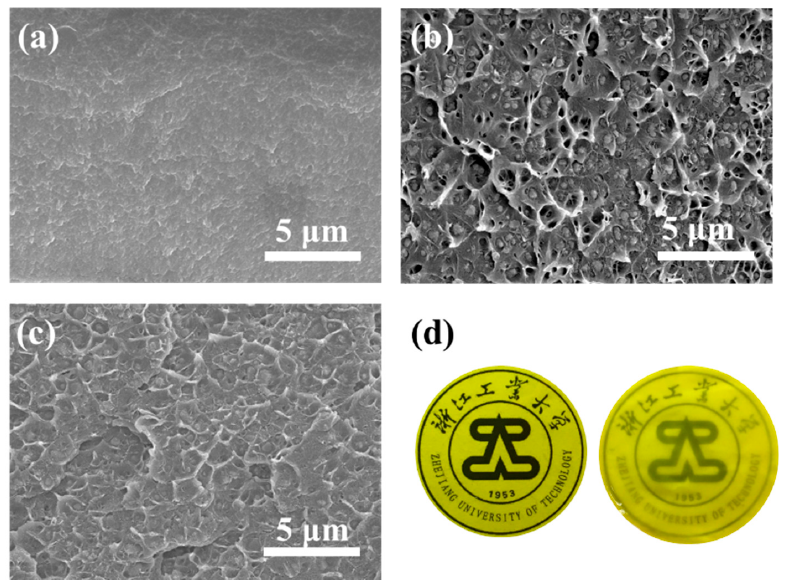
Figure 3. ( a ) SEM images of pure PIM-1 membrane; ( b ) UiO-66-NH 2 /PIM-1 MMM with 20 loadings; ( c ) UiO-66-NH 2 @IL/PIM-1 MMM with 20 loadings; ( d ) Photos of pure PIM-1 membrane (Left) and 20 wt.% UiO-66-NH 2 @IL MMM (Right).